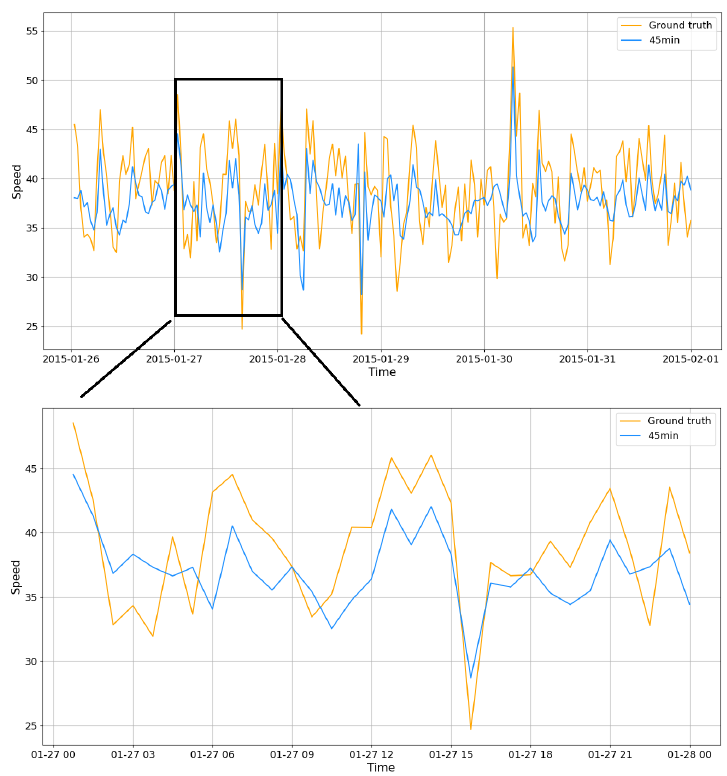
Figure 9. Result for prediction horizon of 45